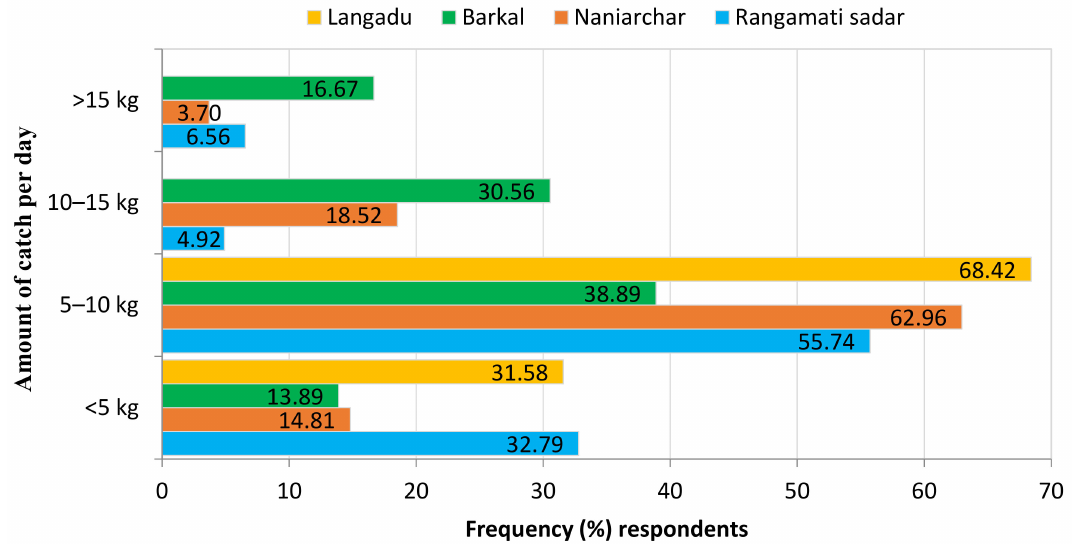
Figure 7. Status of catch/harvest per day by the individual fishers in the four studied Upazila of Kaptai Lake.